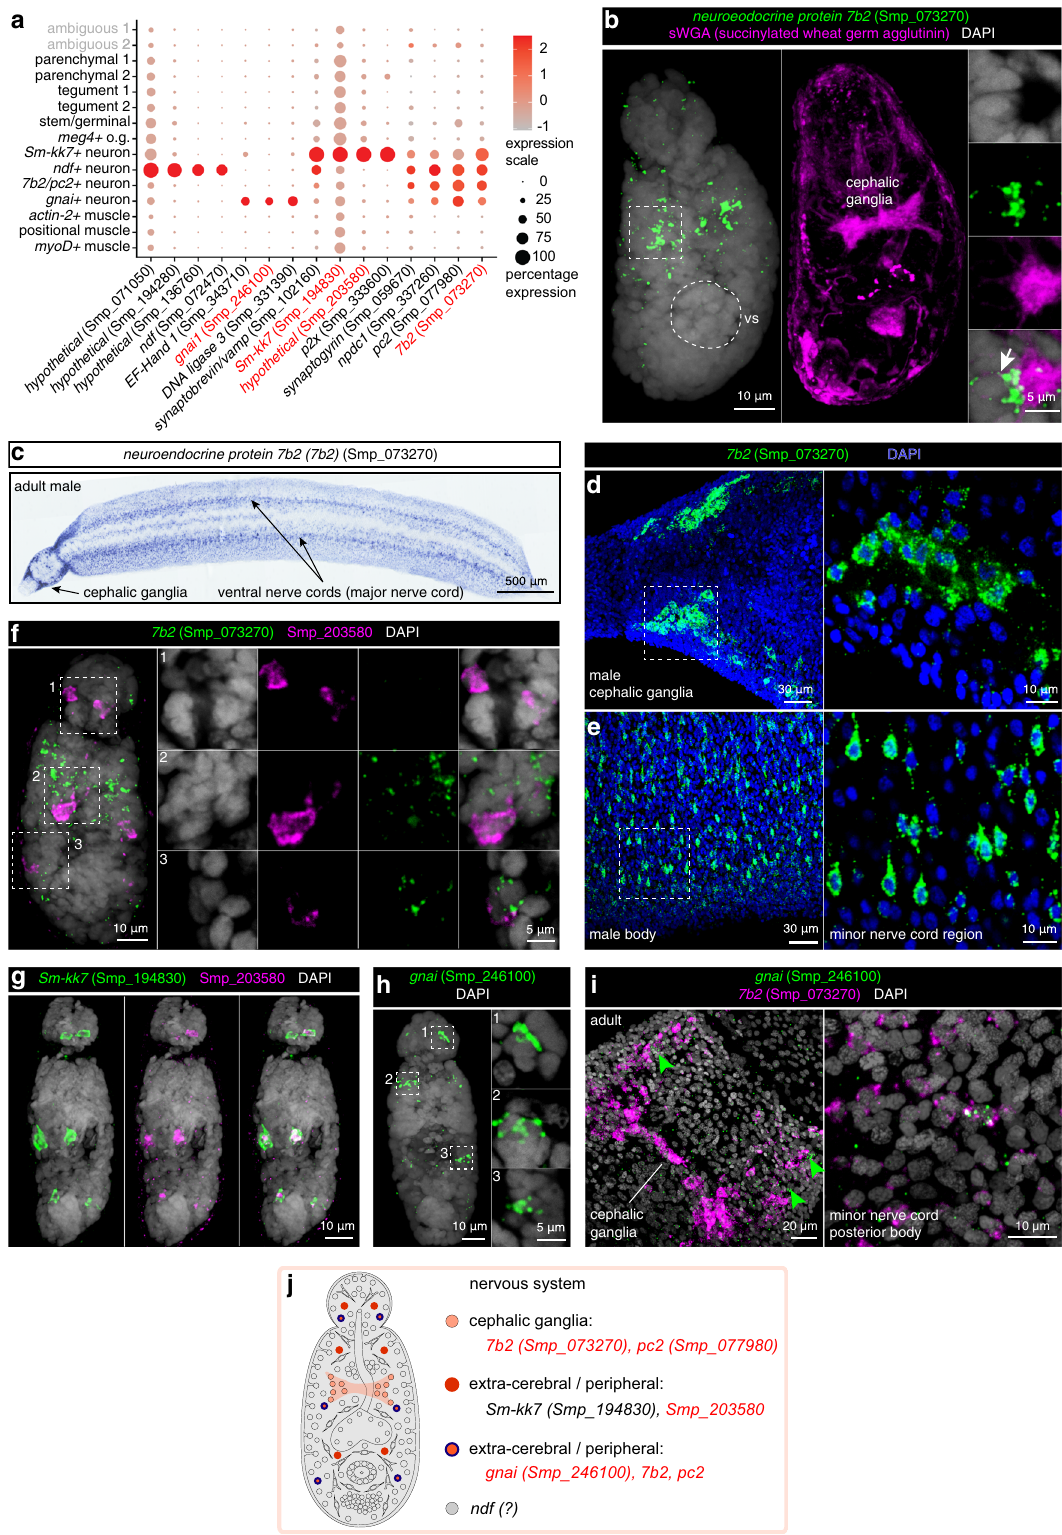
ISH experiments. Importantly, the latter allowed us to validate key marker genes for each of the cell clusters, spatially mapping the cell populations in both schistosomula and adult worms and linking transcriptomic pro fi les to anatomical features of the